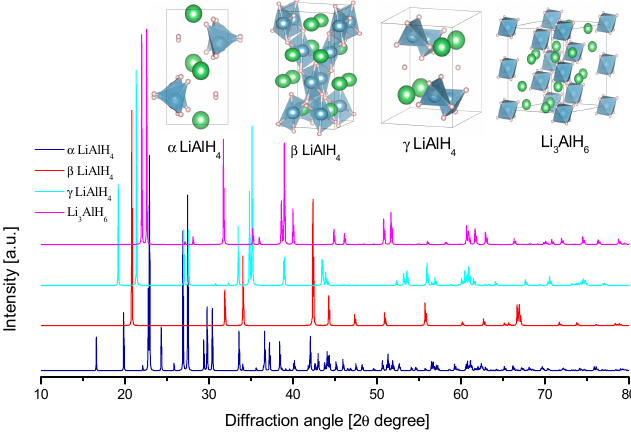
ff raction patterns ( λ = Cu k α 1